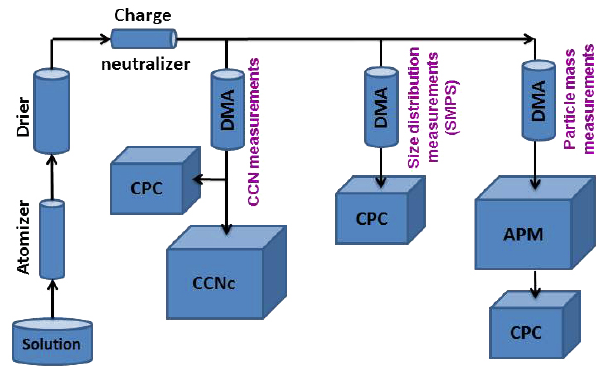
Figure 1. Schematic of the experimental setup and three types of measurements: CCN activity measurements, size distribution mea- surements by SMPS and particle mass analysing by